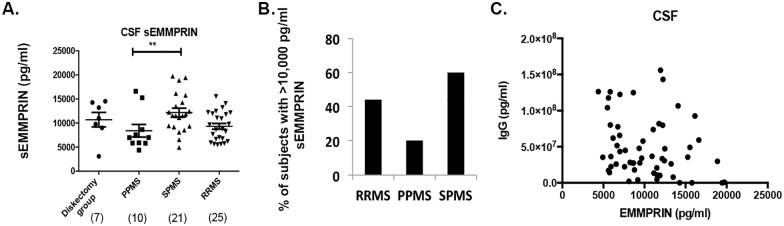
sEMMPRIN in CSF: higher levels in SPMS compared to PPMS subjects.(A) While CSF sEMMPRIN from the MS subtypes did not differ from discectomy group (3093.3–14530.0 pg/ml), the CSF sEMMPRIN from SPMS subjects (4928.4–19748.4 pg/ml) was statistically higher compared with PPMS CSF (4388.8–16614.4 pg/ml). Further, RRMS CSF sEMMPRIN levels (5617.9–15528.2 pg/ml) did not differ from other groups. Each entry represents the value from individual subjects performed in duplicate. Values are represented in pg/ml and the line data represents mean ± SEM. Groups were compared using one way ANOVA with Tukey’s post hoc test, **p<0.01. (B) Graph represents percentage of subjects in each group with sEMMPRIN levels >10,000 pg/ml. (C) Scatter plot showing correlation analysis between CSF IgG levels and sEMMPRIN in all the MS subjects. The sEMMPRIN in CSFs did not correlate with CSF IgG levels (Pearson correlation, r of -0.2382, p = 0.07).